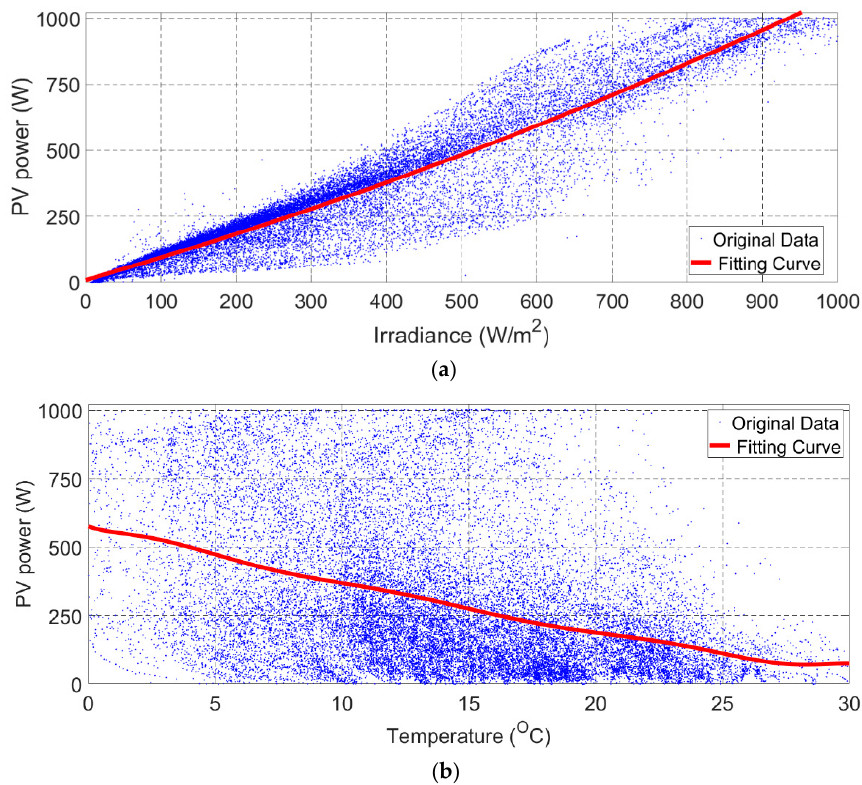
Figure 7. Fitting curve of ( a ) PV power versus irradiance; ( b ) PV power versus temperature.